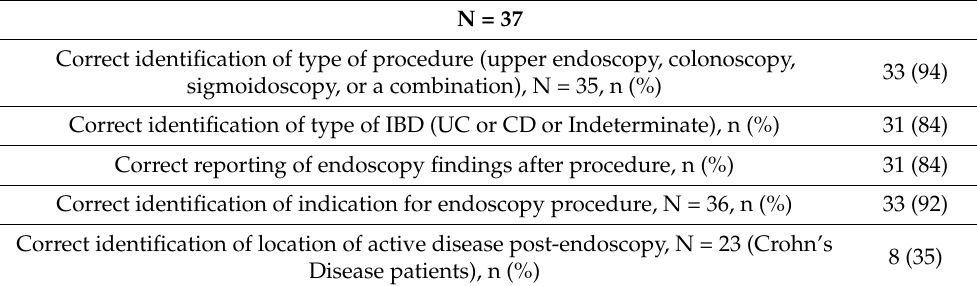
Table 2. Characterizing patient knowledge of their disease and endoscopy findings. N = 37 Correct identification of type of procedure (upper endoscopy,